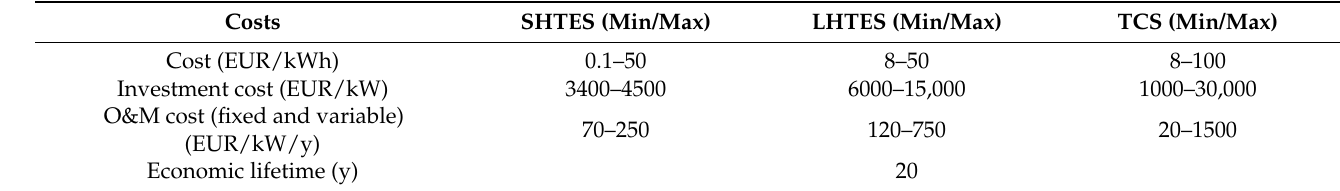
Table 11. Current typical values of TES prices.